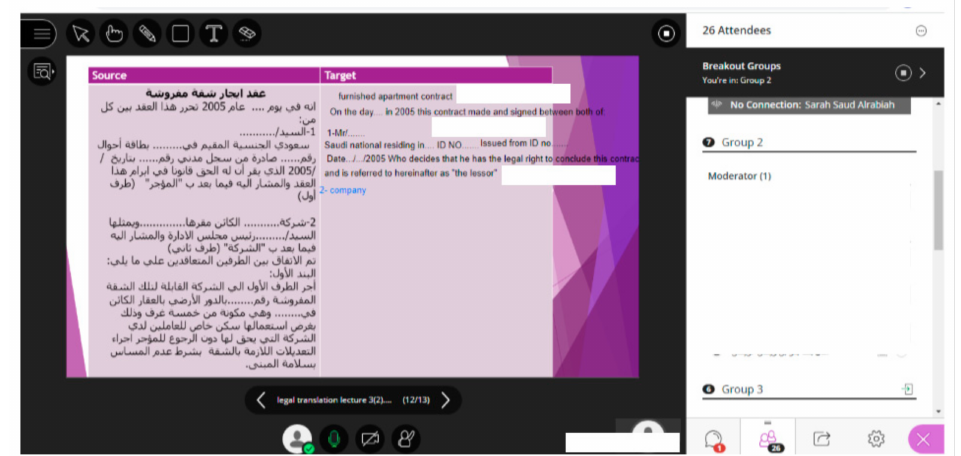
Figure 1. Sample of students’ interaction in one of the groups.